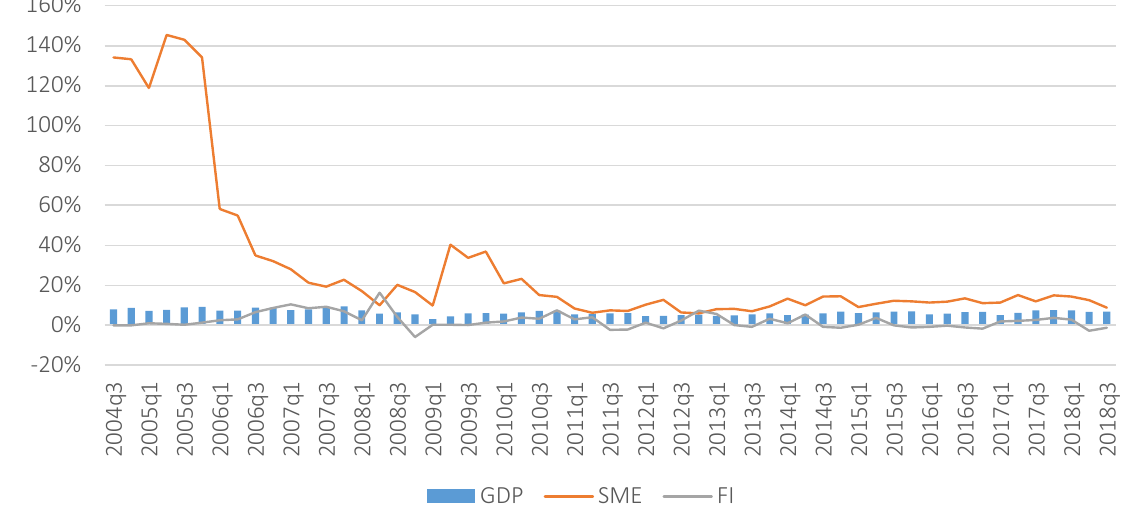
Figure 3. Stock market (SME, FI) and economic growth